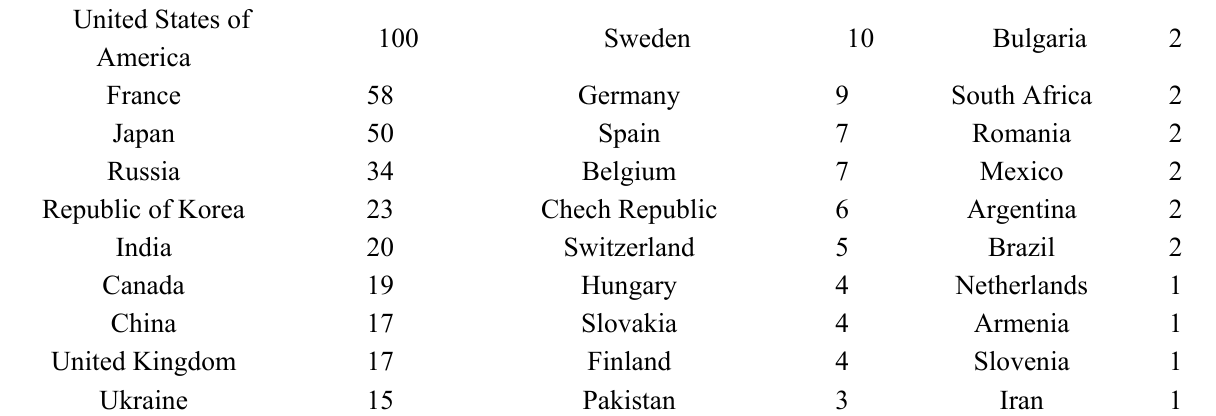
Table 6. Nuclear reactors in operation worldwide in